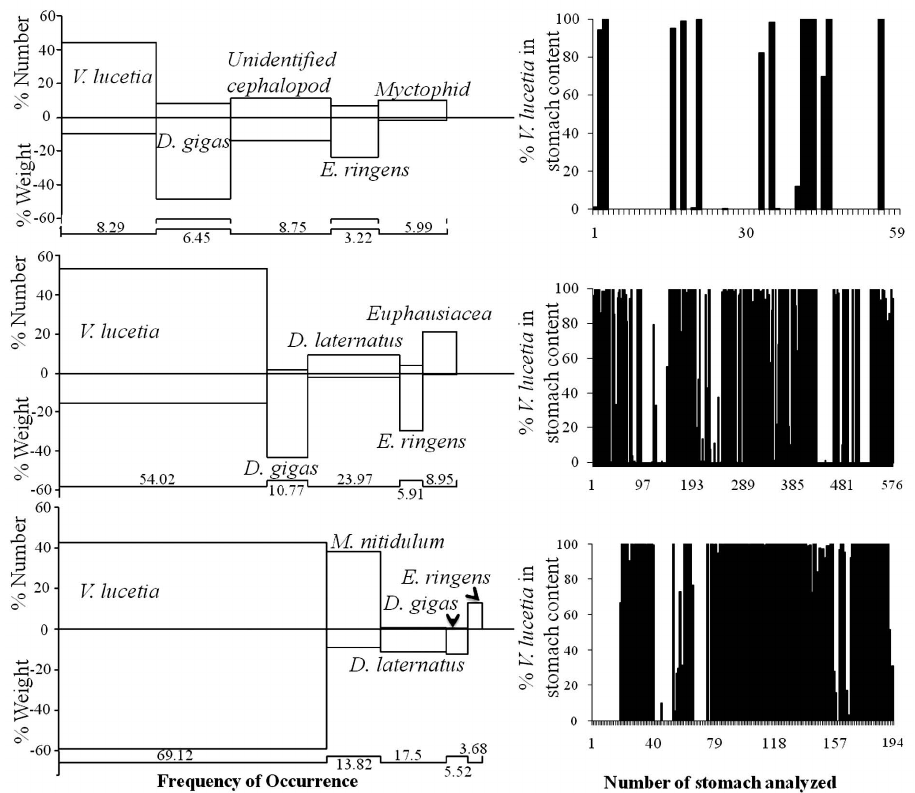
Fig . 2. – Left: Composition by percentage number (%N) and weight (%W)(vertical axis) and frequency of occurrence (%FO, horizontal axis) of the main prey found in the stomach contents of jumbo squid collected in the Humboldt Current System off Peru (March 2007, June-July 2008 and November-December 2008). Right: Percentage of V. lucetia found in the stomach contents of jumbo